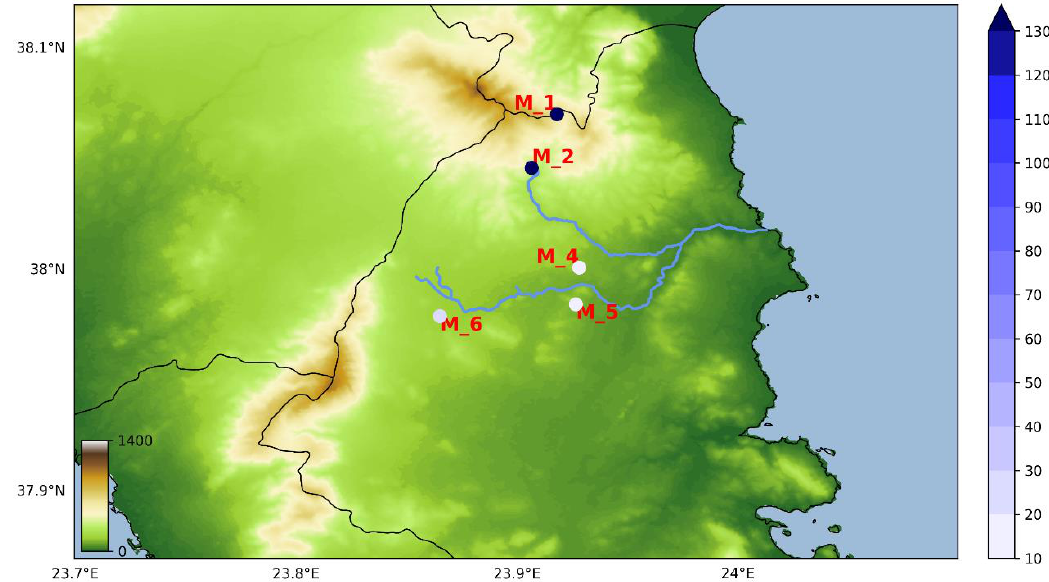
Figure 10. Topography of the study area and total accumulated rainfall observed in five meteorological stations during the event #12 (22 February 2013, 0200 UTC to 1100 UTC).